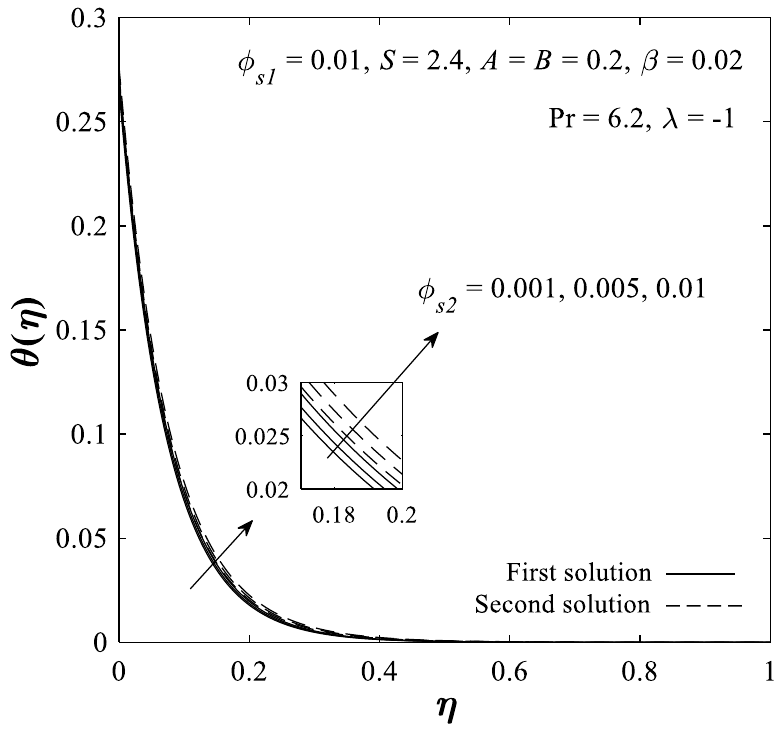
Figure 15. Temperature profile   θ η for varied 